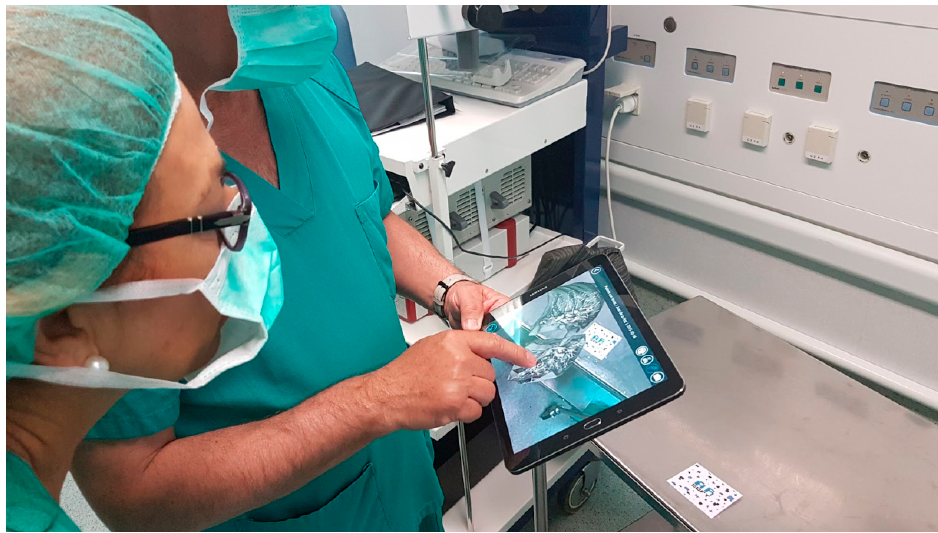
Figure 14. Visualization image of a segmented lung in the augmented reality platform with a